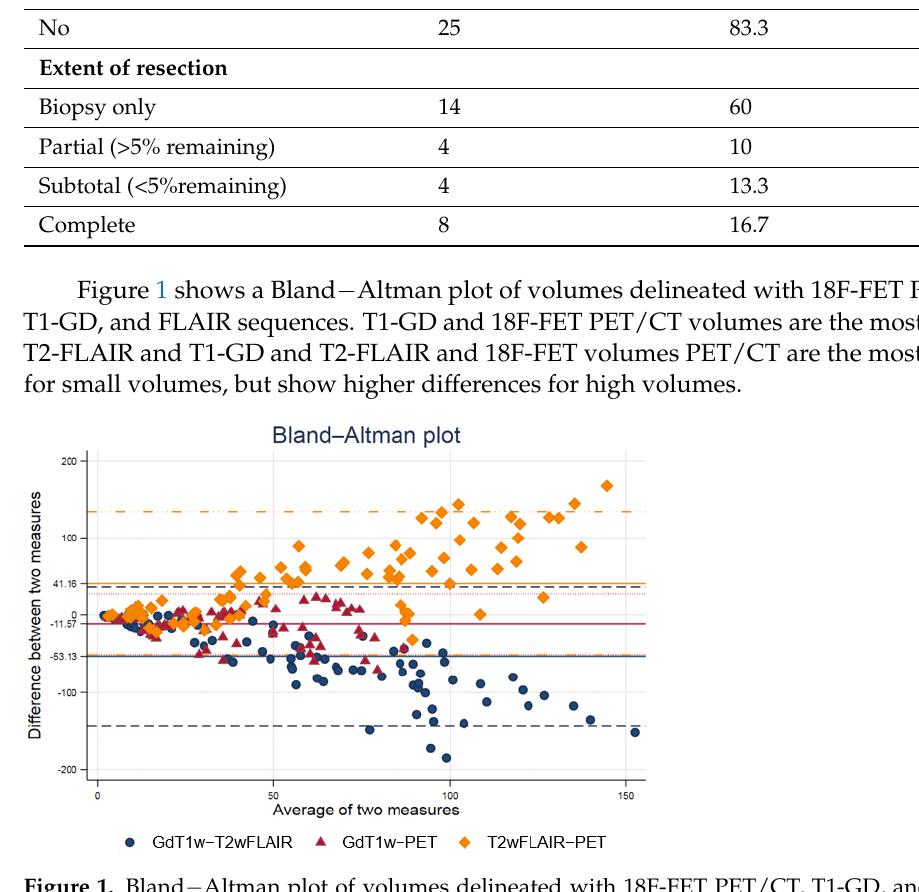
Figure 1. Bland − Altman plot of volumes delineated with 18F-FET PET/CT, T1-GD, and FLAIR sequences. T1-GD and 18F-FET PET/CT volumes are the most similar. T2-FLAIR and T1-GD and T2-FLAIR and 18F-FET volumes PET/CT are the most similar for small volumes, but show higher differences for high volumes. Figures 2 and 3 show examples of volumes delineated with the different sequences.